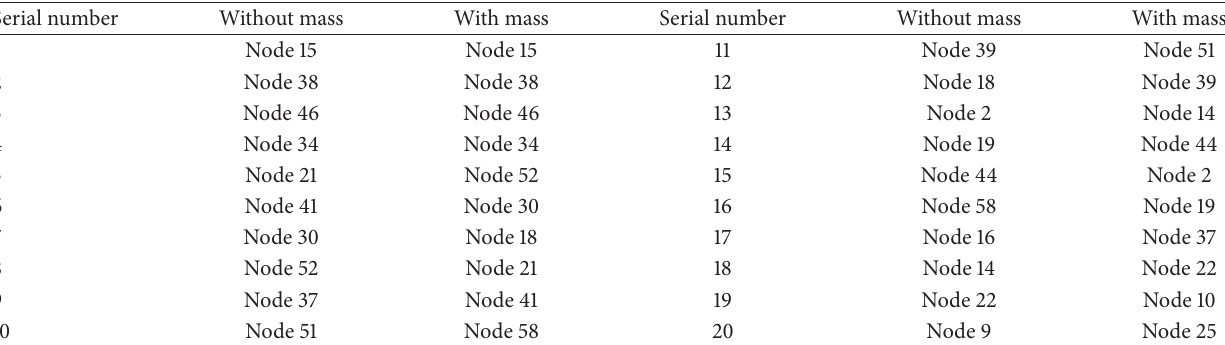
Table 5: The top 20 nodes of Dolphin social